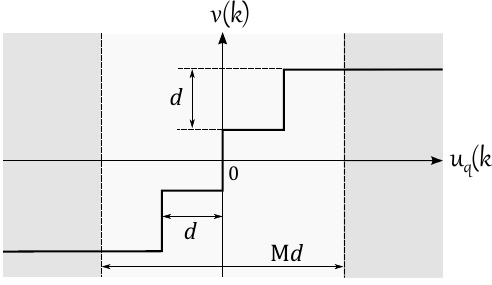
Figure 3. Example of a static quantizer q ( · ) for Q NNR ( M =